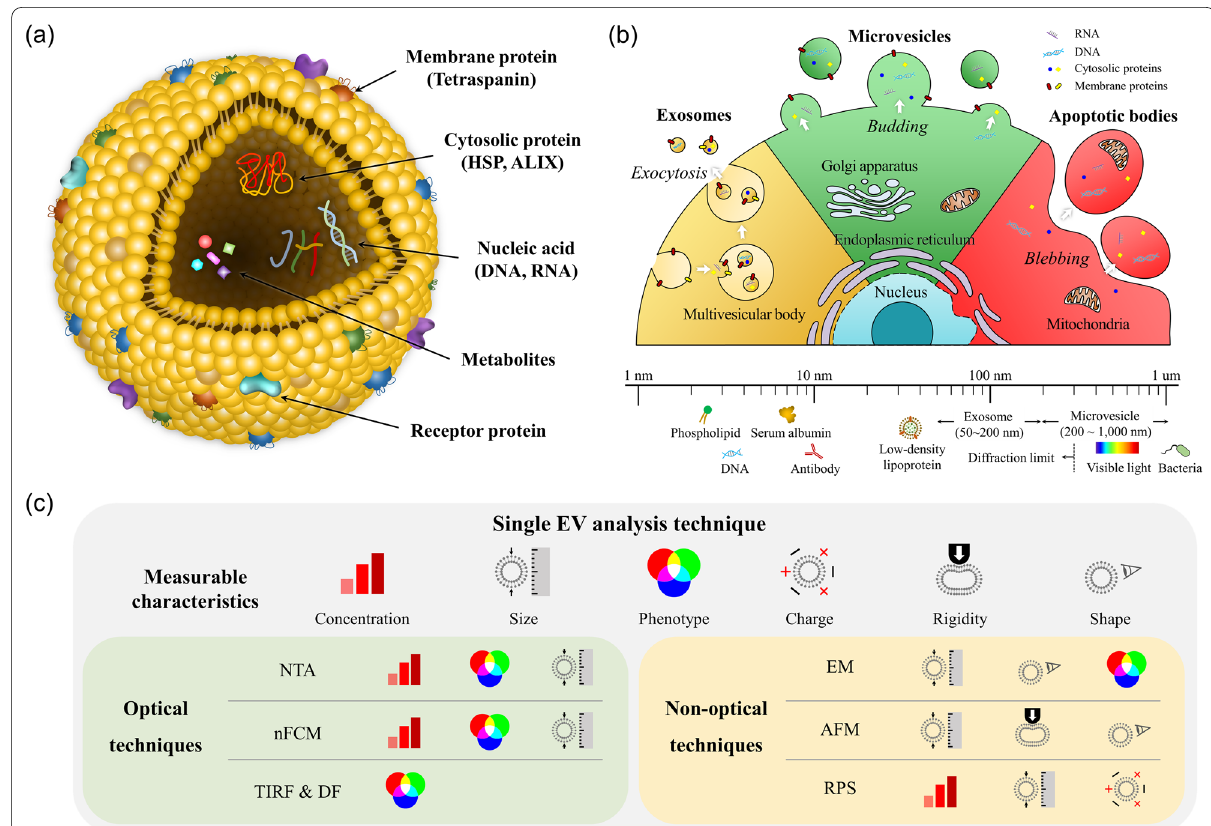
Fig. 1 a Schematic diagram of the extracellular vesicle and its components. b Biological origin of the extracellular vesicle and the scale comparison of nanostructures. c Measurable abilities of single EV analysis techniques. NTA nanoparticle tracking analysis, nFCM nano-flow cytometry, TIRF total internal reflection fluorescenc, DF dark-field, EM electron microscopy, AFM atomic force microscopy, RPS resistive pulse